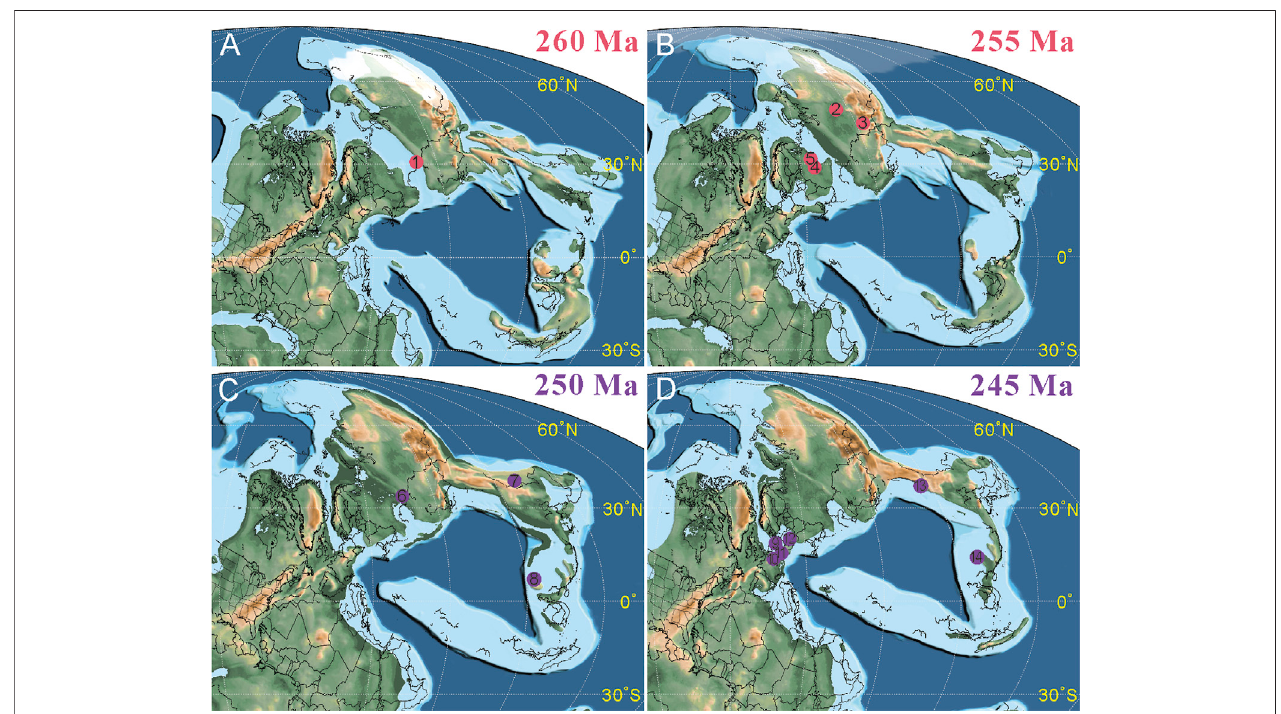
FIGURE 3 | Paleogeographic distribution of Chauliodites during the Middle Permian to Middle Triassic: (A) (1) Orenburg, Russia; (B) (2) Krasnoyarsk, Russia; (3) Kemerovo, Russia; (4) Vladimir, Russia; (5) Vologda, Russia; (C) (6) Orenburg, Russia; (7) Nomgon Sum, Mongolia; (8) Yunnan, China; (D) (9) Lower Saxony, Germany; (10) Vosges, France; (11) Bavaria, Lower Franconia and Thurngia of Germany; (12) Mniów, Poland; (13) Shaanxi, China; (14) Guizhou, China. Paleogeographic maps modi fi ed from Scotese (2021).